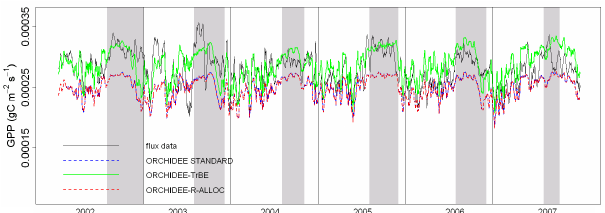
Figure 9. A separate simulation where the standard version was adjusted only for allocation and respiration (ORCHIDEE-R- ALLOC) shows that the altered GPP pattern is entirely due to seasonal changes in V cmax . Changing the respiration and allocation has no significant impact on GPP. Run-sequence 10 day moving averages at Guyaflux including daytime data (8h- 16h) of measured and modelled GPP. Dry periods are shaded in gray (<100 mm month -1 ).